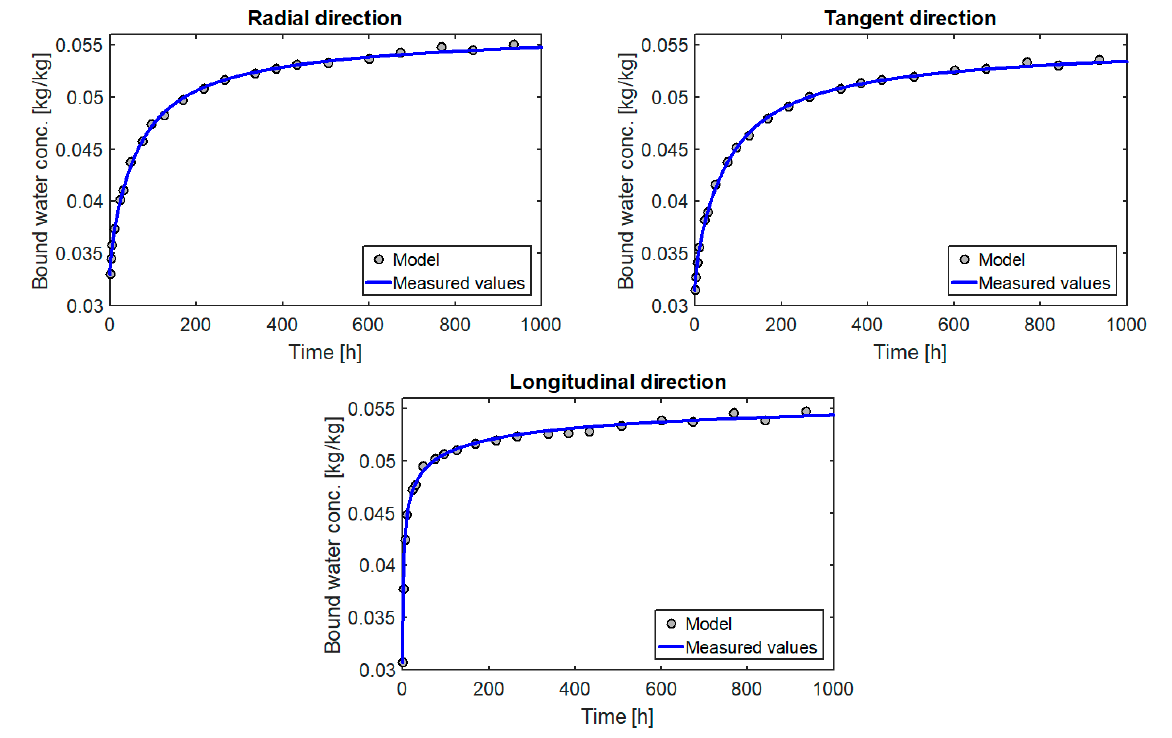
Figure 6. Diagrams of changes of moisture content for the pine samples. Table 2. Coefficients obtained for the pine samples.